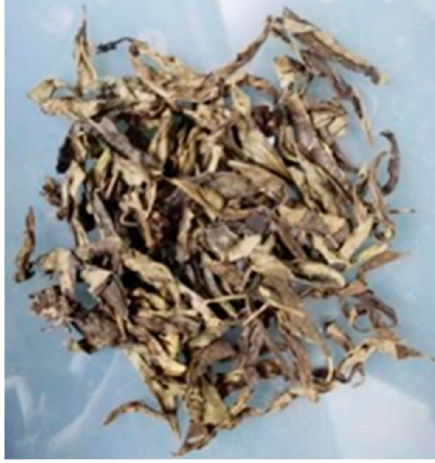
Figure 16. Main impurities in Lan tea.